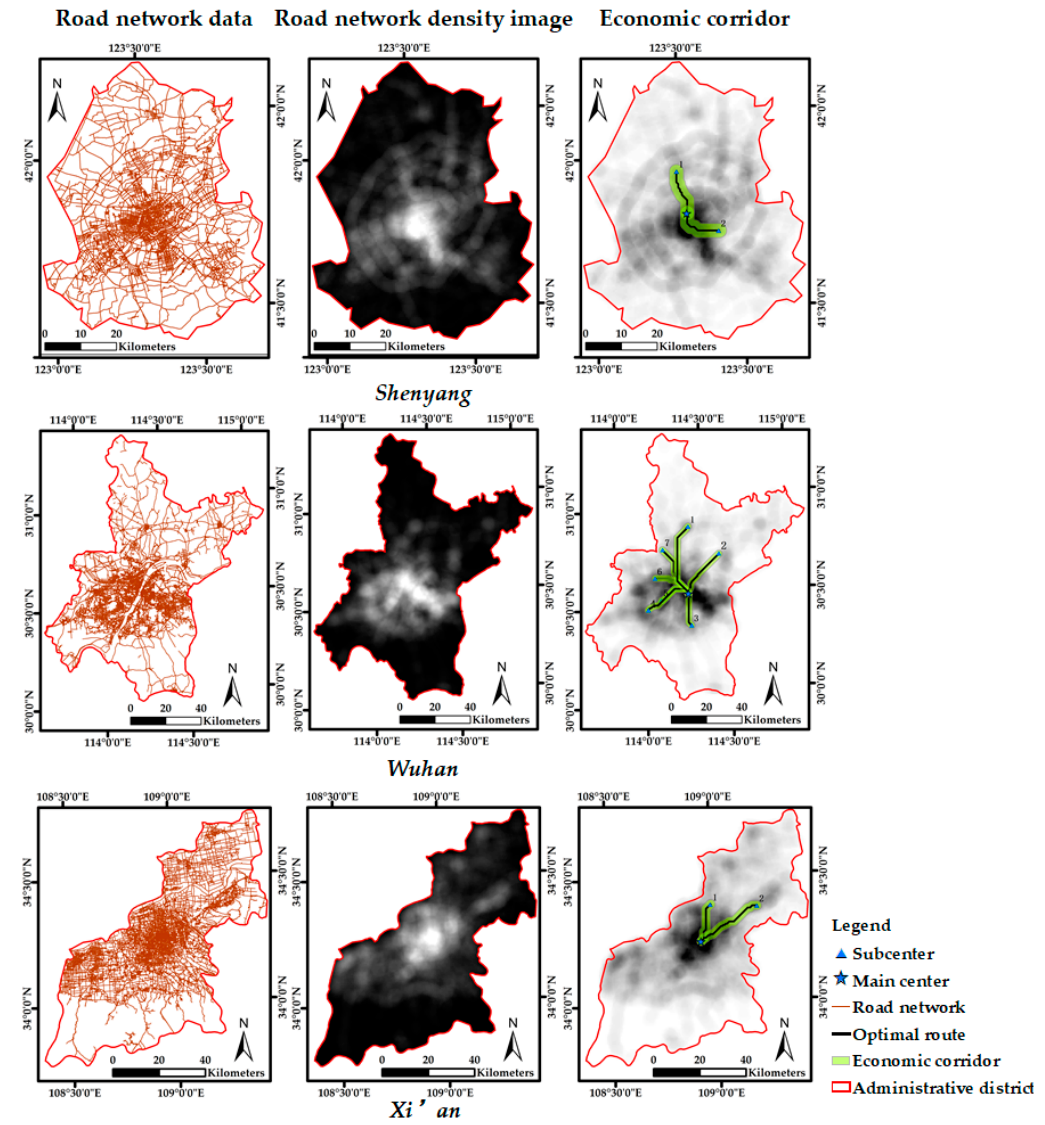
Figure 9. Economic Figure 9. Economic corridors.